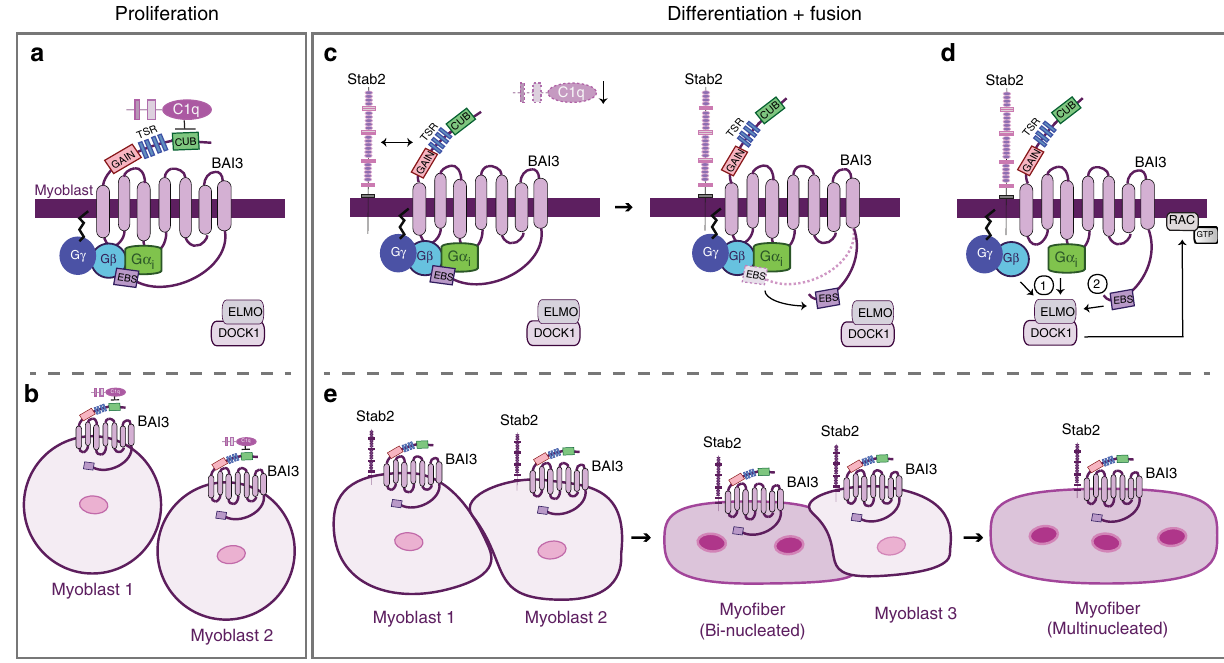
Fig. 9 Working model. a , b In muscle progenitors, BAI3 activity is inhibited by the interaction of the secreted protein C1qL4 binding to the CUB domain found in the extracellular region of BAI3. c When differentiation is initiated, the expression of C1qL4 decreases while the expression of Stabilin-2 increases. The interaction between BAI3 and Stabilin-2 leads to the activation of the canonical signaling of G protein and the exposure of the ELMO Binding site (EBS) of BAI3. d These events lead to the recruitment of the ELMO/Dock1 complex by two signals: 1-the G proteins broadly recruit ELMO/DOCK1 to the membrane and 2-this recruitment facilitates a direct interaction of ELMO with BAI3 via a direct interaction of ELMO with the EBS of BAI3. These interactions collectively promote myoblast fusion. e The mixed population fusion assays conducted in this study demonstrated that both BAI3 and Stabilin- 2 receptors are required on both fusing cells for both myoblast – myoblast and myoblast – myotube